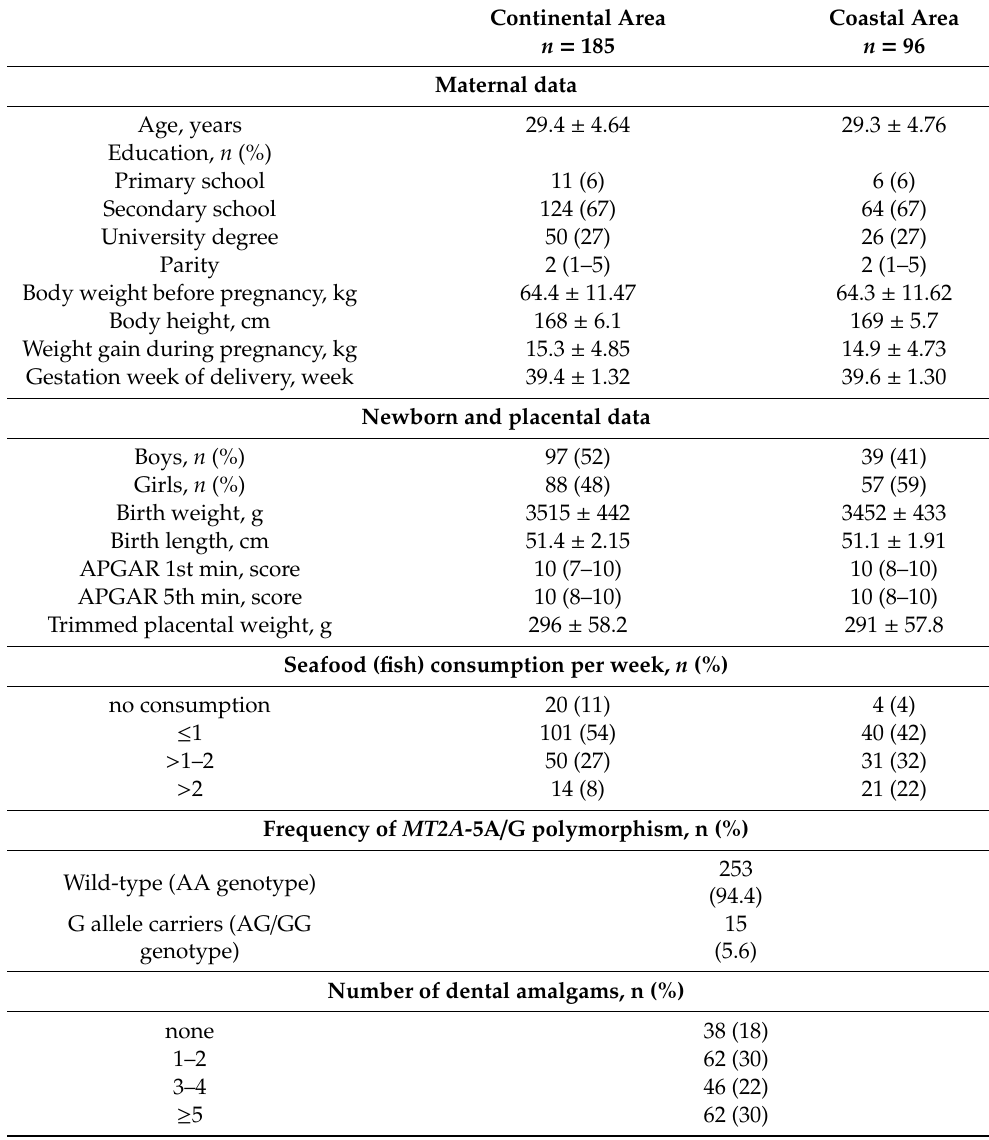
Table 1. General characteristics of the participants from Croatia included in the study ( n =